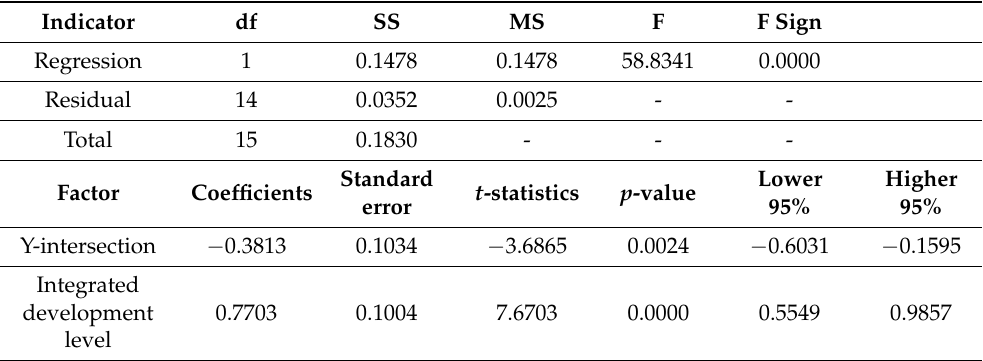
Table 8. Key indicators of regression analysis of the relationship between the integrated and general development of the studied enterprises.